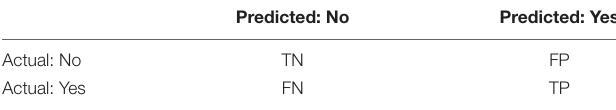
TABLE 2 | A confusion matrix with N = 2.